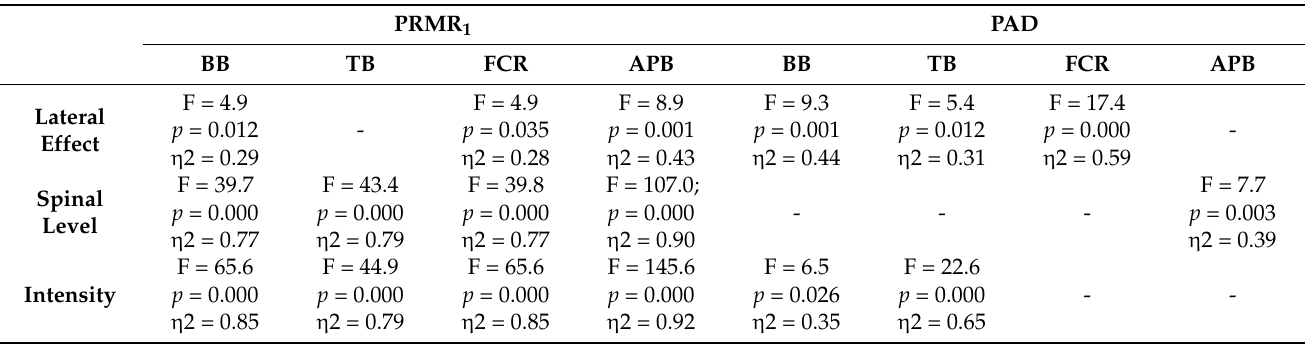
Table 2. Results of three-way ANOVA for comparison of stimulus intensity, spinal level and lateral cathode location in PRMR 1 and PAD. In all cases where significant lateral effects are reported, greater responses were observed with contralateral cathode arrangement. In all cases of spinal levels, greater responses were observed at the most caudal level (level of C8 spinal